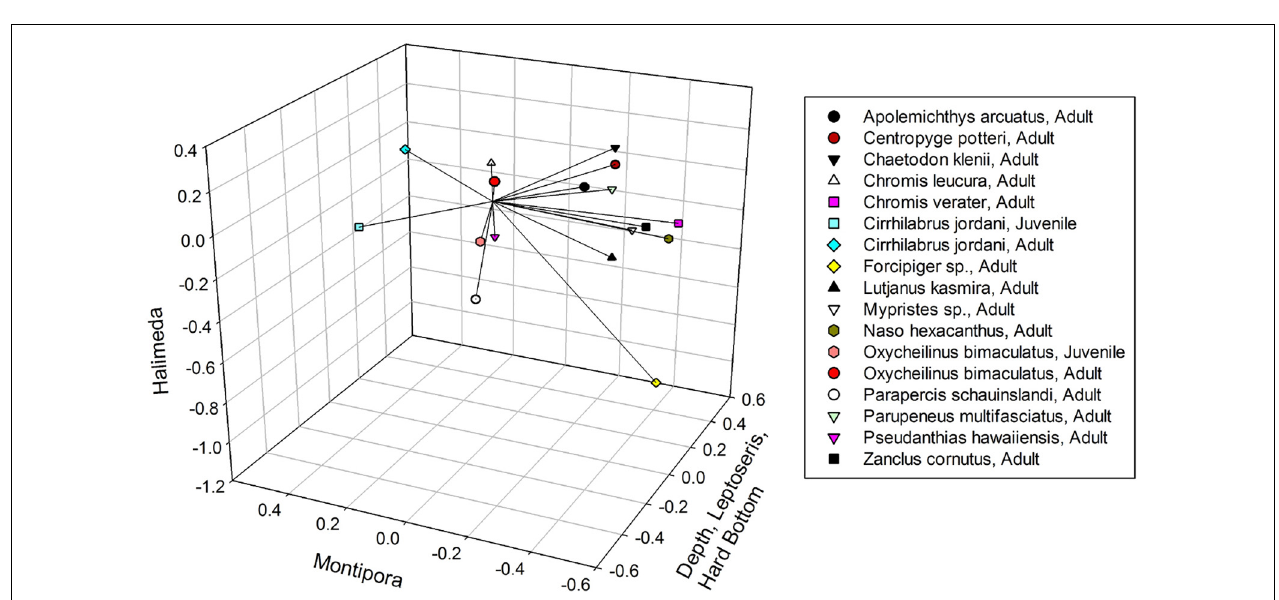
FIGURE 5 | Non-metric Multidimensional Scaling plot of fish species, showing their Kendall Tau correlations with the three axes (vectors). Axis one is correlated with depth, Leptoseris and hard bottom. Axis three is correlated with Halimeda. Axis two is not correlated with any environmental variable.